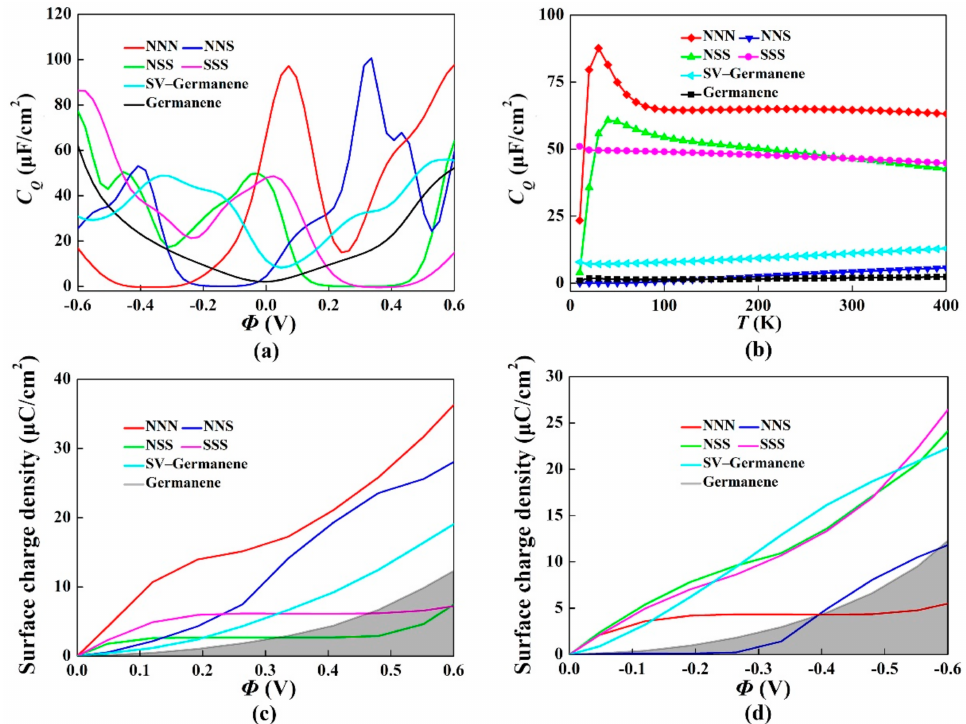
Figure 6. ( a ) Calculated quantum capacitance of the N/S co-doped with single-vacancy ger- manene; ( b ) Change of C Q with temperatures in the scope of 0 K–400 K, the consequences gained in 4 × 4 supercell; ( c , d ) Surface charge density vs. Φ between − 0.6 V and 0.6